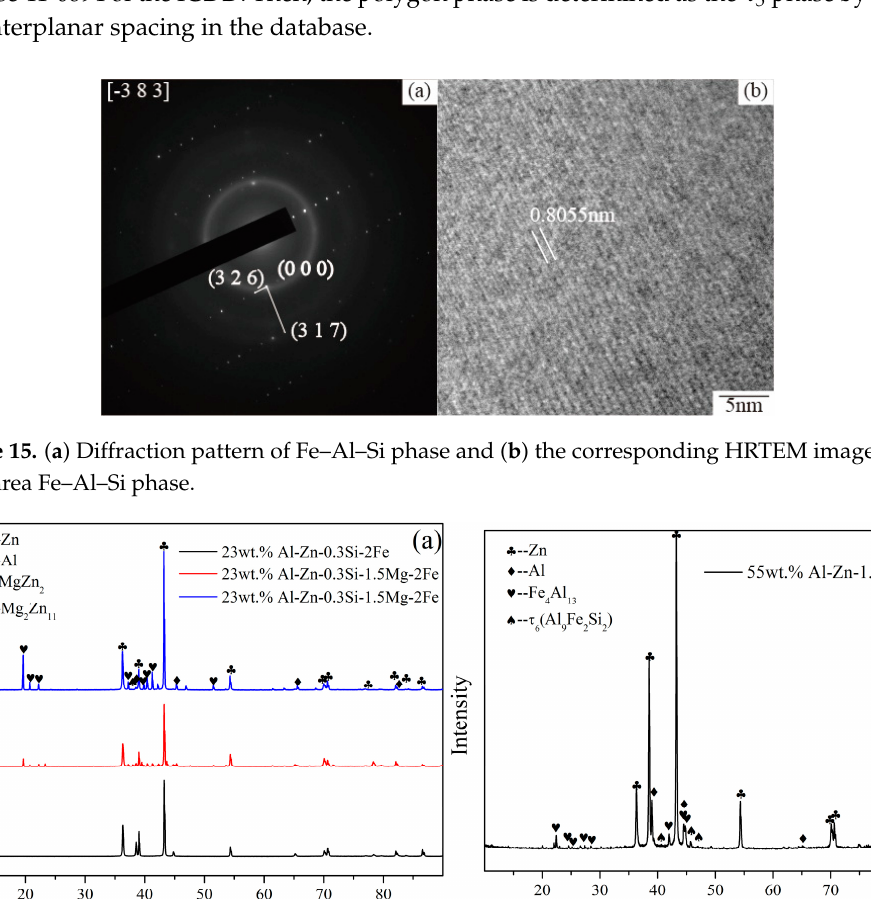
Figure 14. TEM bright field image of Fe-Al-Si phase: ( a ) EDS point result of 1, ( b ) EDS point result of 2.